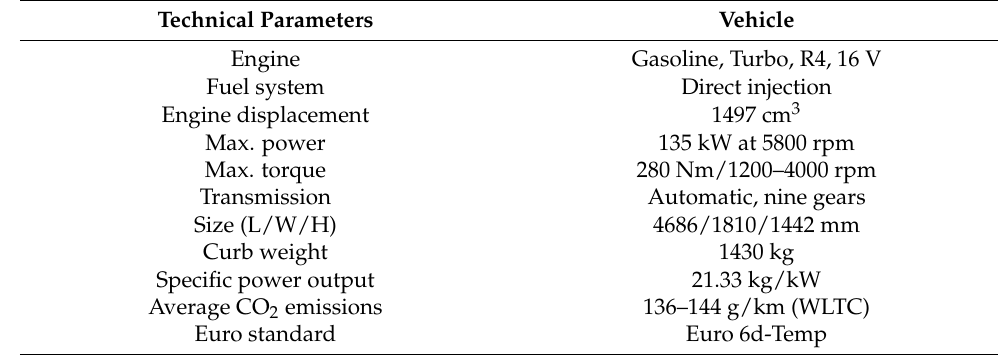
Table 1. Technical parameters of the tested vehicles.